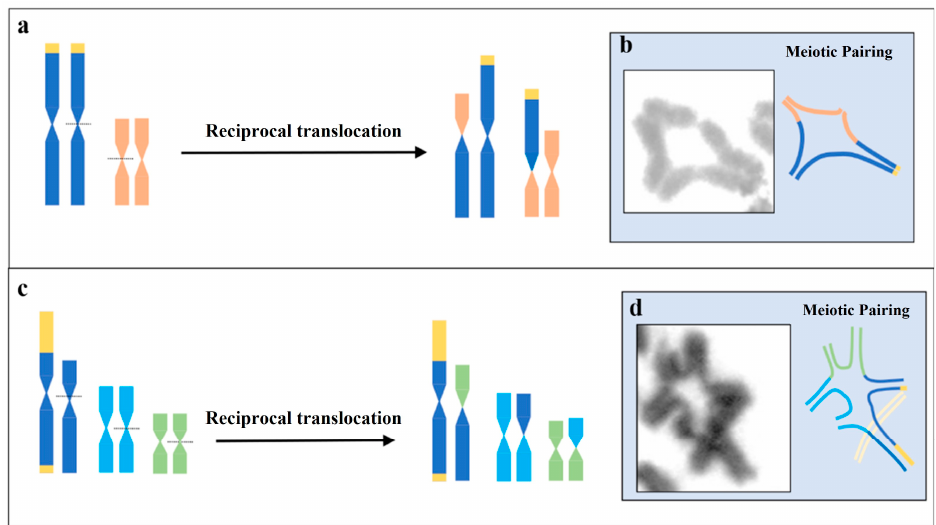
Figure 5. Schematic interpretation for observed translocations in B. amazonicus cytotype B: ( a ) origin and ( b ) metaphase I pairing of the quadrivalent association; ( c ) origin and ( d ) metaphase I pairing of the hexavalent association. Yellow regions in the schemes correspond to 45S rDNA sites.